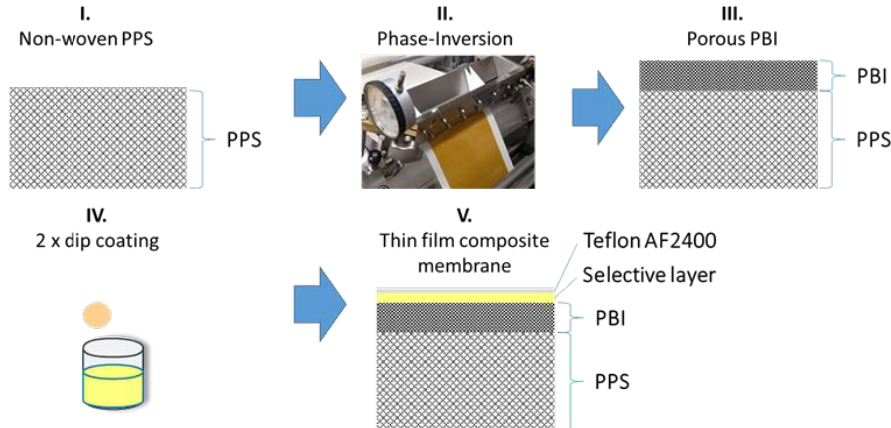
Figure 1. Sketch of the production steps to form thin-film composite membranes (TFCMs) with four layers: polyphenylene sulfide (PPS) as a non-woven support, polybenzimidazole (PBI) as a porous support, Matrimid ® or 6FDA-6FpDA as a selective layer, and Teflon ® AF 2400 as a protective layer.